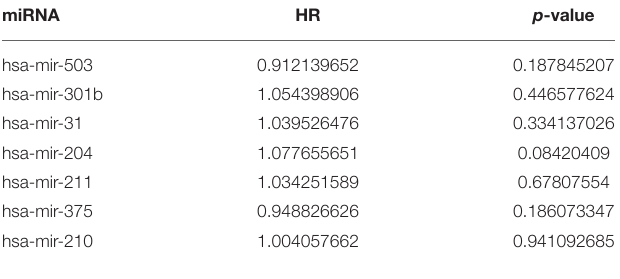
TABLE 7-2 | miRNA univariate Cox regression results.